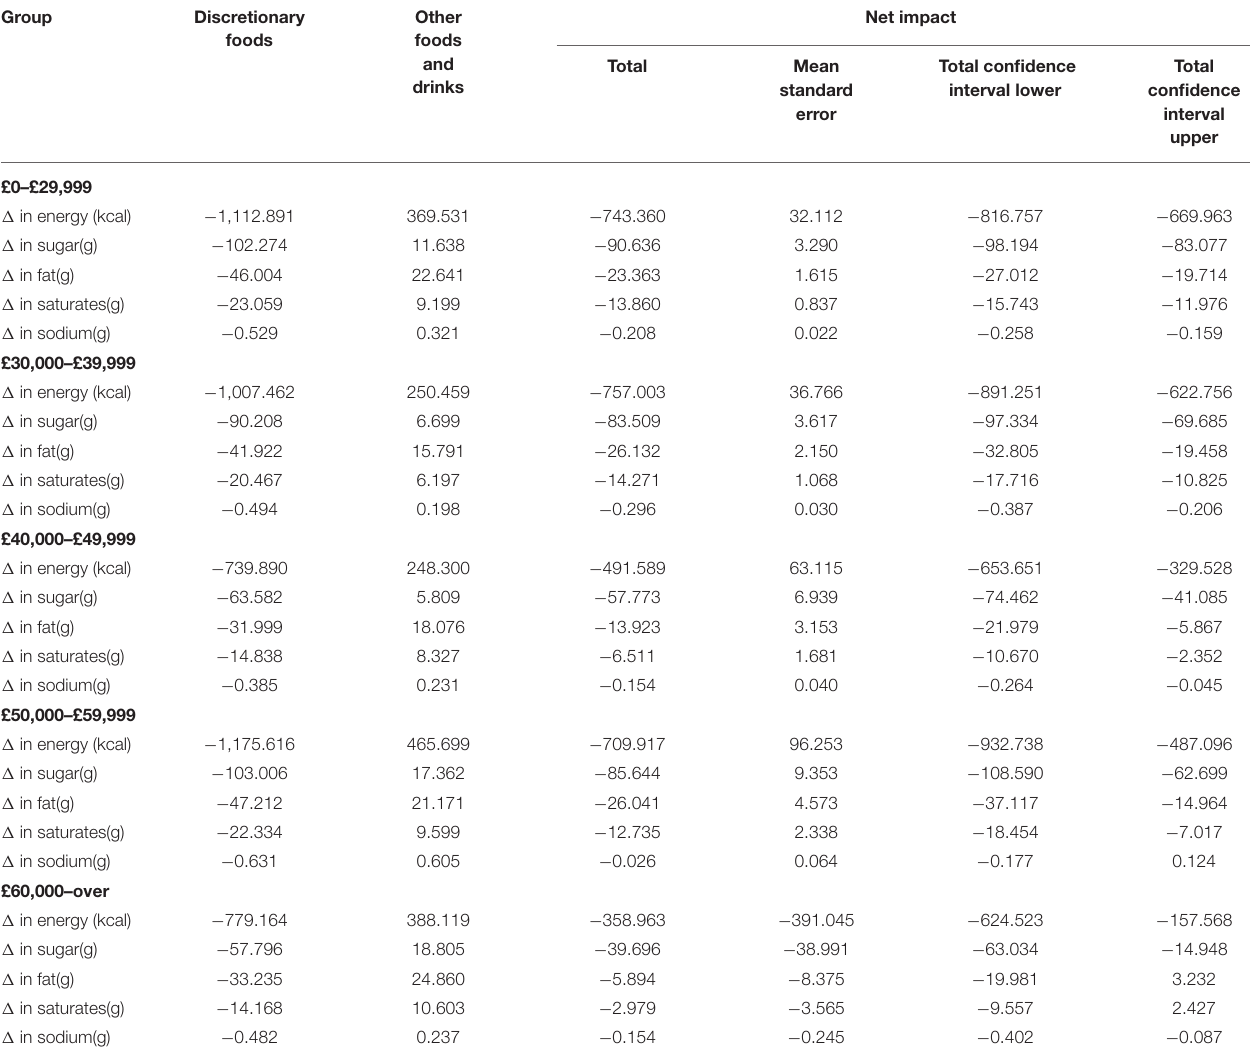
TABLE 4 | Net results of the simulation on discretionary foods-by income classification (Changes are in per capita per week terms). Group Discretionary